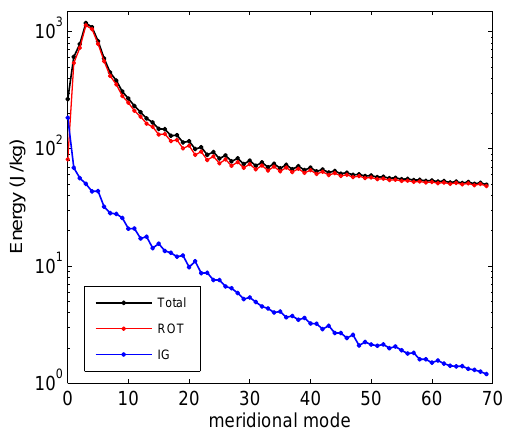
Figure 8. Distribution of total, balanced and inertio-gravity wave energy in meridional modes. Summation is performed over all ( m,k ) and the mean state ( k = 0 ) is not included.